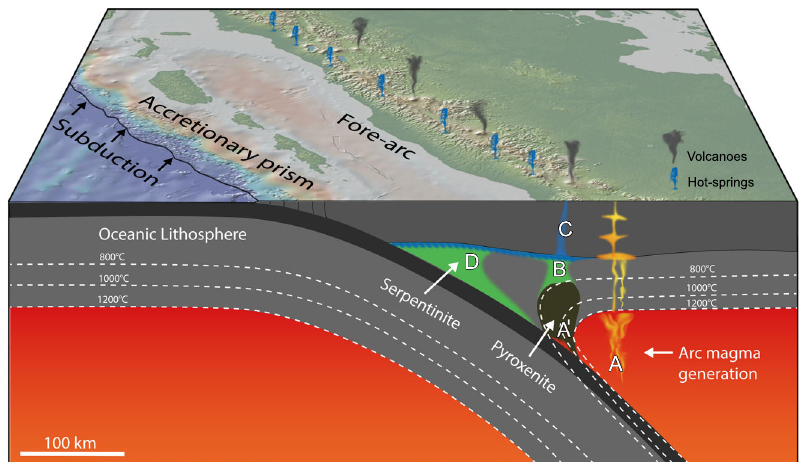
Fig. 2 Subduction zone with fore-arc metasomatism model. Arc magmas form below the volcanic front ( A ), where fl uid- fl uxed melting of mantle peridotites occurs. In front of the region of arc magma generation (A ′ ) subducted sediments melt and their hydrous melts rise and react with peridotite. Since temperatures in front of the arc (A ′ ) are below the solidus of peridotite, hydrous sediment melt reacts to form a phlogopite-pyroxenite metasome. Fluids expelled by phlogopite-pyroxenite formation rise through the mantle wedge B into the crust C to form reservoirs and hot springs. Map modi fi ed from GeoMapApp, www.geomapapp.org/ with Global Multi-Resolution Topography (GMRT) 47